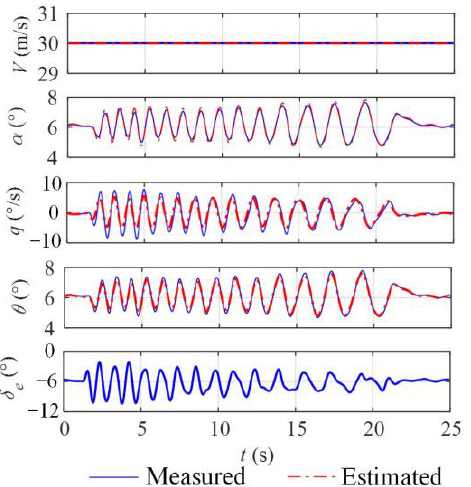
Figure 13. Comparison of simulation results for the identified model with wind tunnel test